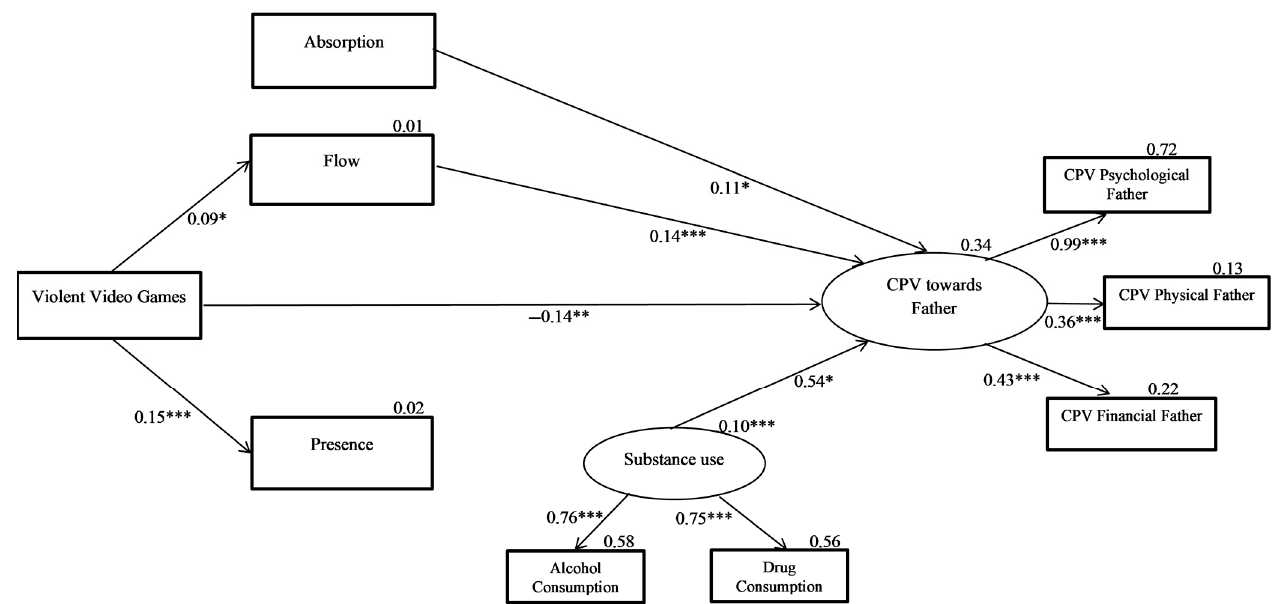
Figure 1. Predictive model of CPV towards mothers (final model). Rectangles represent observed variables and ovals represent latent variables. Values listed are standardized coefficients. * p < 0.05. *** p < 0.001.